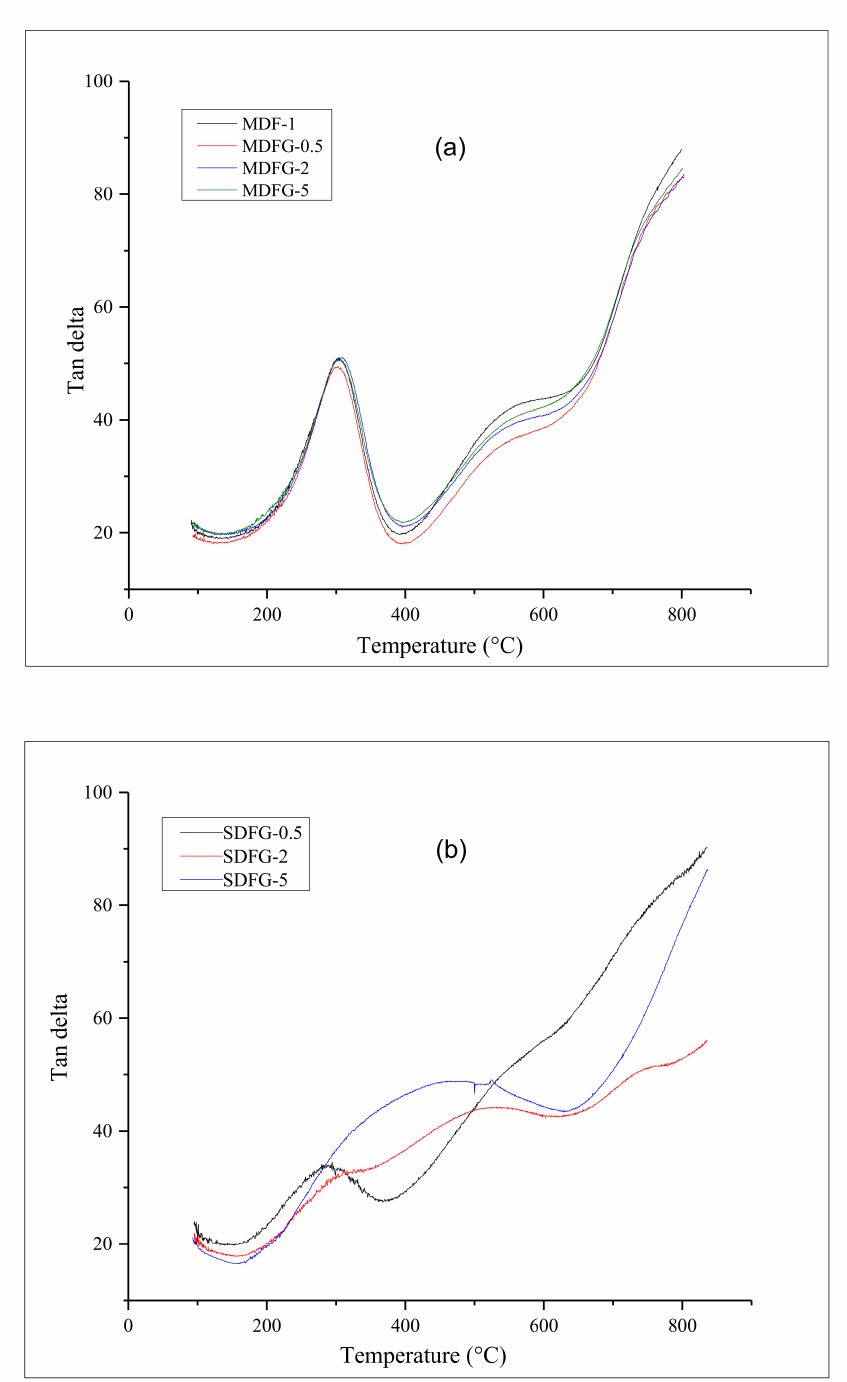
Figure 5. Overlay graphs of tan delta of nanocomposites prepared by: ( a ) melt mix-method, and ( b ) prepared by solution-cast